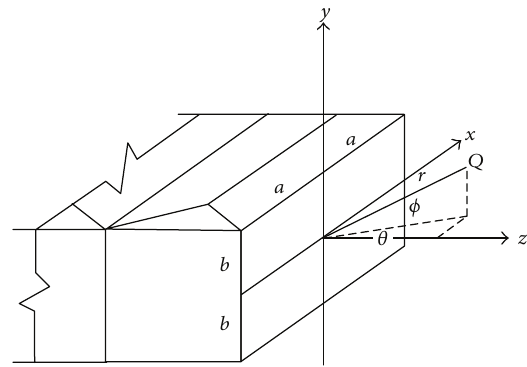
Figure 3: Coordinate coefficient of rectangle source acoustic field of OPFC element.